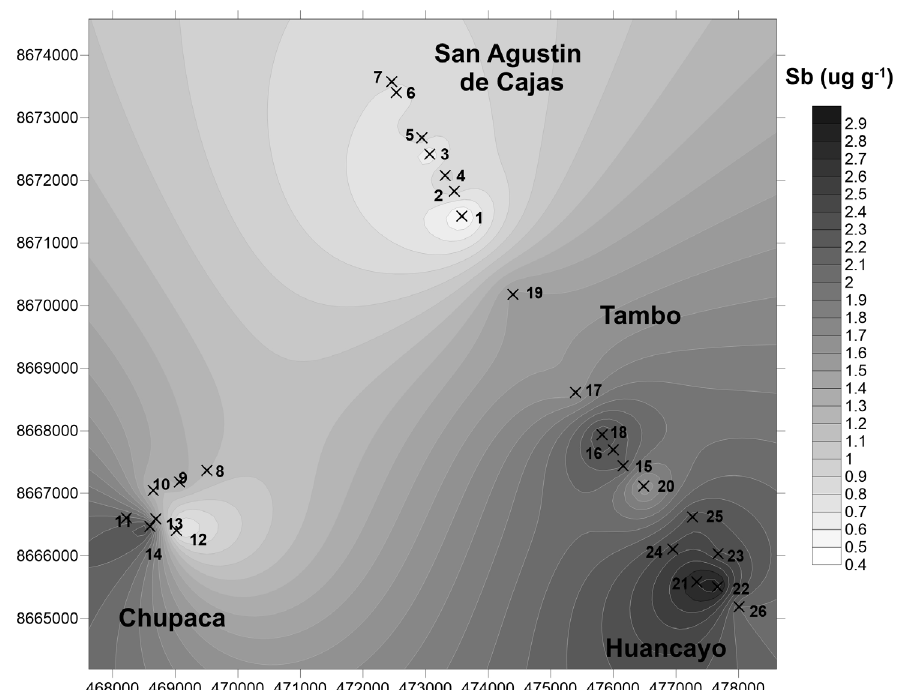
Figure 6. Distribution map of Sb